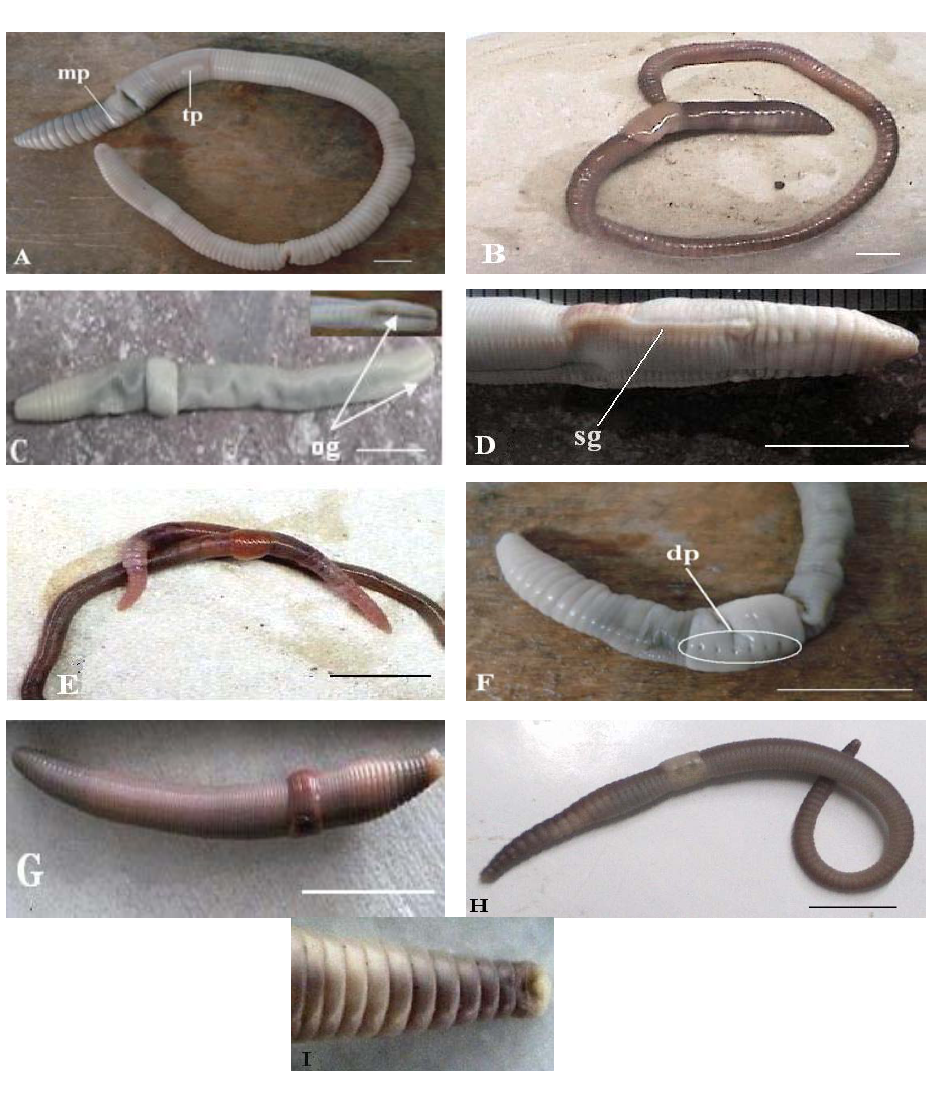
(og: obvious grooves, sg: seminal groove), E, F) Aporrectodea rosea (dp: dorsal pores), G,H,I) Dendrobaena byblica